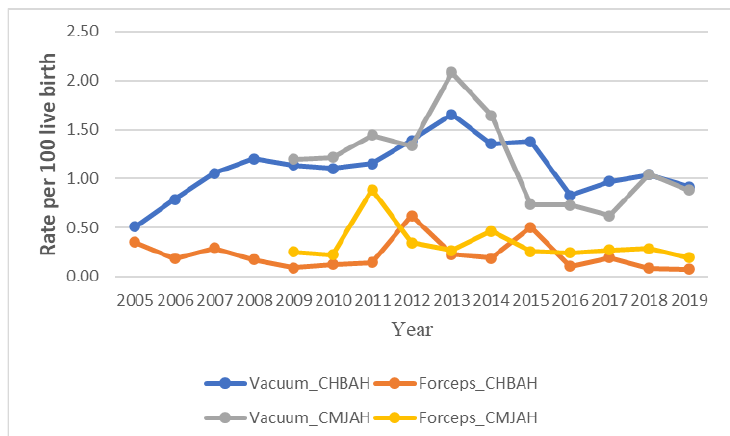
Figure 4. Trends in types of operative vaginal delivery rate at two academic hospitals, Johannesburg (2005 – 2019).